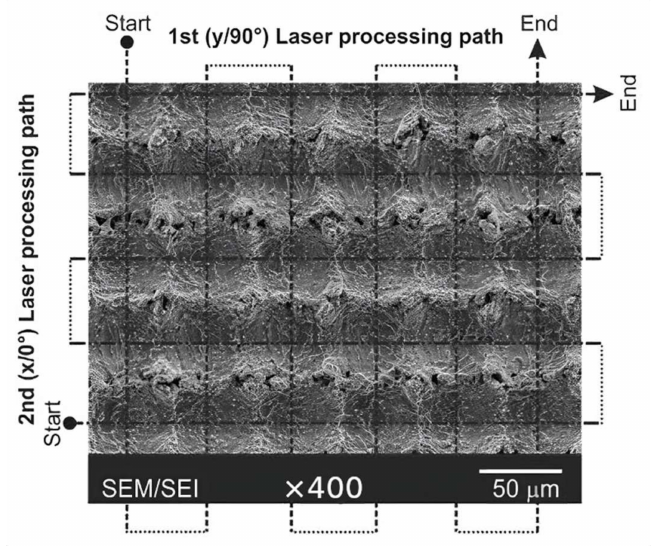
Figure 3. SEM micrographs of laser-textured surfaces with direction of laser passes. Adapted/redrawn with permission from [81], Elsevier,